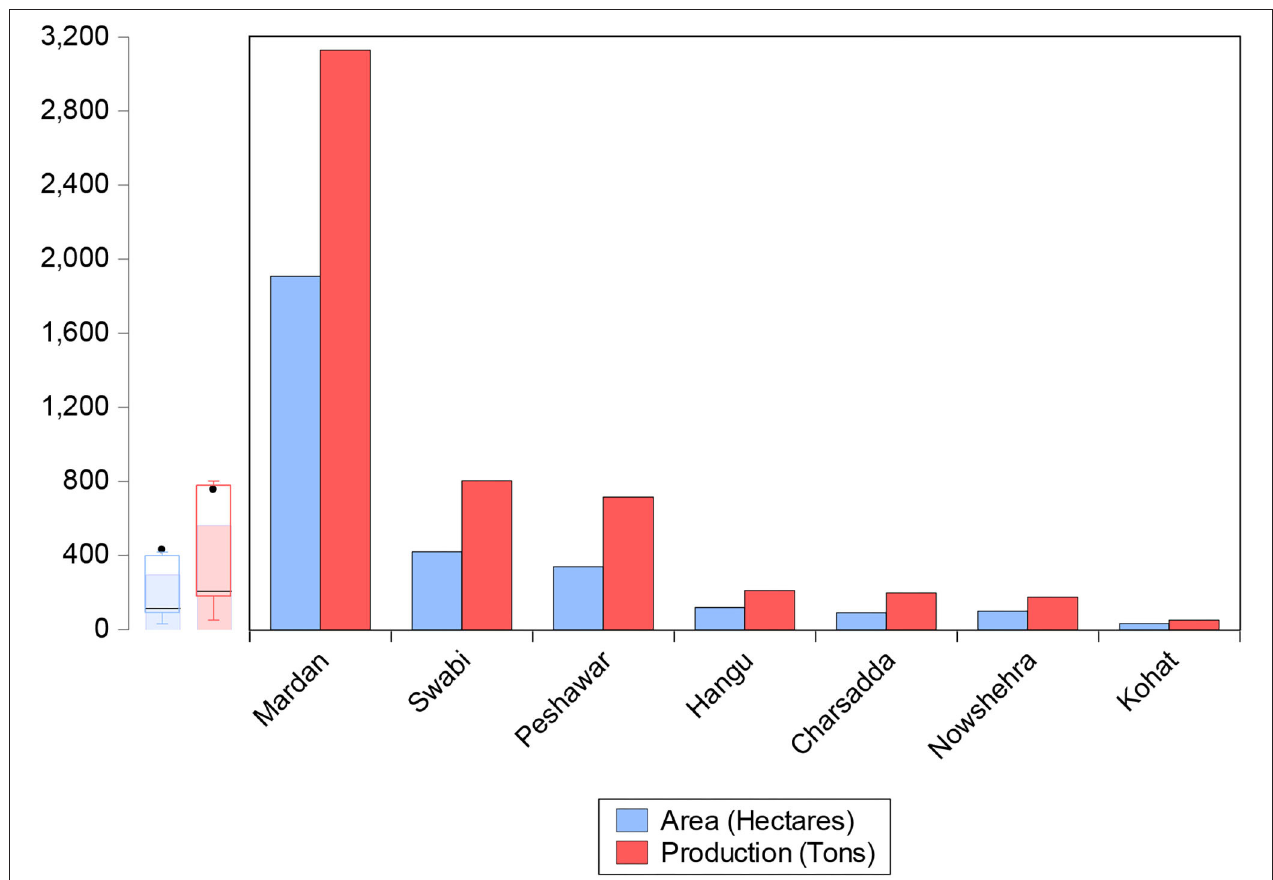
FIGURE 1 | Area and production of maize in Zone C KPK (2017/2018). Khyber Pakhtunkhwa Bureau of Statistics 2017–2018